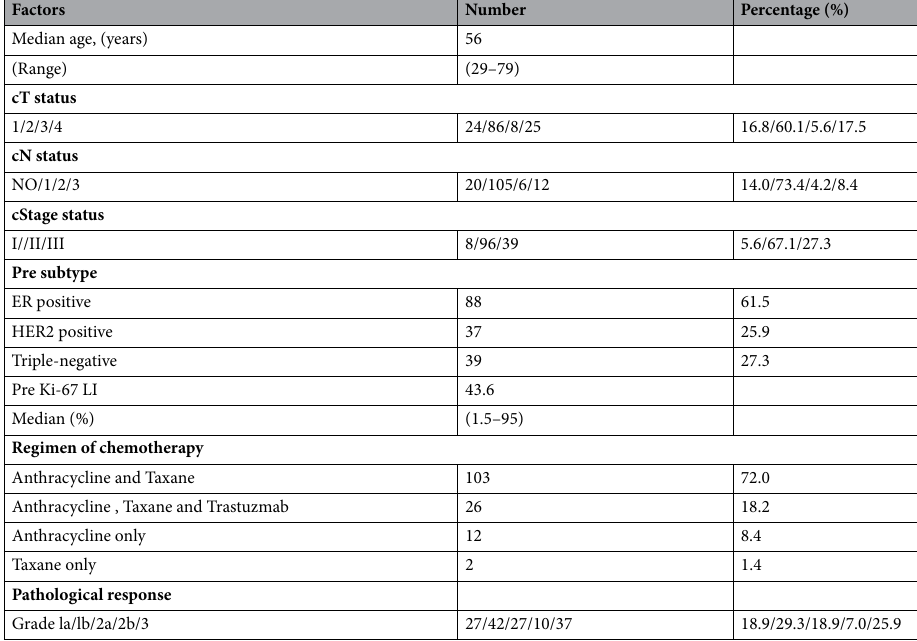
Table 1. Clinicopathological factors of breast cancer patients with chemotherapy before surgery (n = 143). ER, estrogen receptor; HER2, human epidermal growth factor